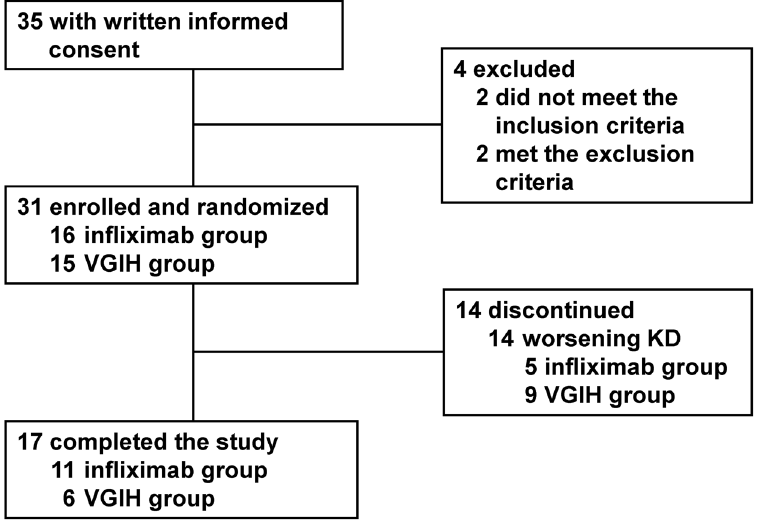
Figure 1. Patient disposition. KD, Kawasaki disease; VGIH, polyethylene glycol-treated human